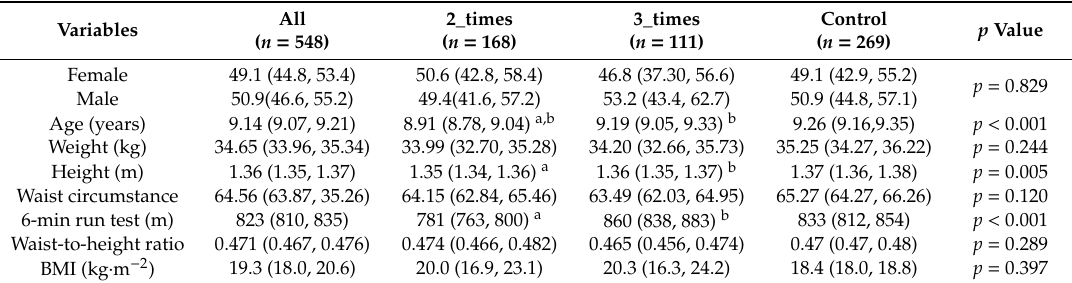
Table 1. Socio-demographic and physical characteristics of the study participants. Data are reported as frequency or mean and (95%